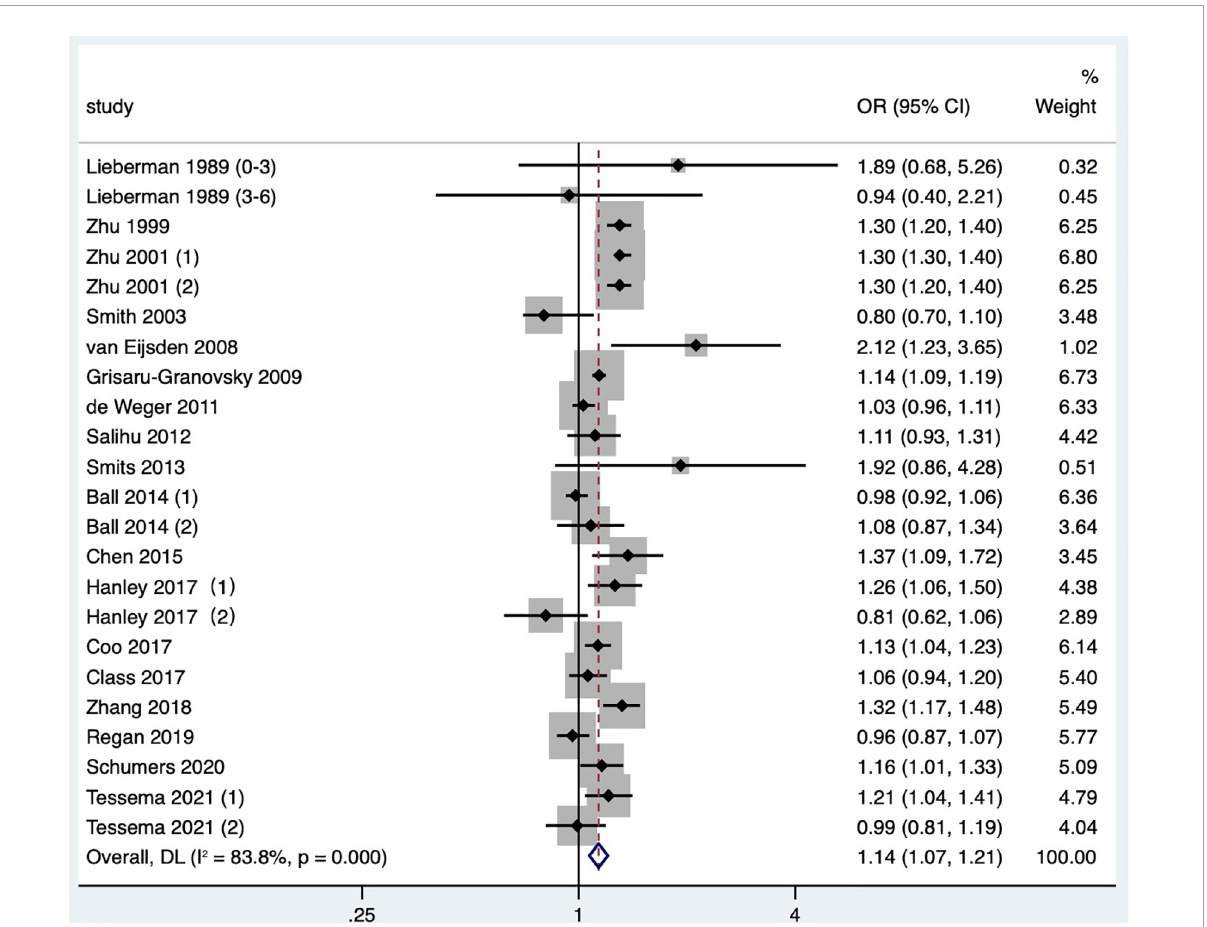
FIGURE5 Meta-analysis forest map of the effects of short IPI on small for gestational age infants. Lieberman et al. (13) (0–3) referred to the IPI of 0–3 months vs. 18–23 months; Lieberman et al. (13) (3–6) referred to the IPI of 3–6 months vs. 18–23 months; Zhu et al. (15) (1) was white data, Zhu et al. (15) (2) was black data; Ball et al. (24) (1) was non-matching data, and Ball et al. (24) (2) was within-mother matching data; Hanley et al. (36) (1) was non-matching data, and Hanley et al. (36) (2) was intra-maternal matching data; Tessema et al. (48) (1) was non-matching data, and Tessema et al. (48) (2) was within-mother matching